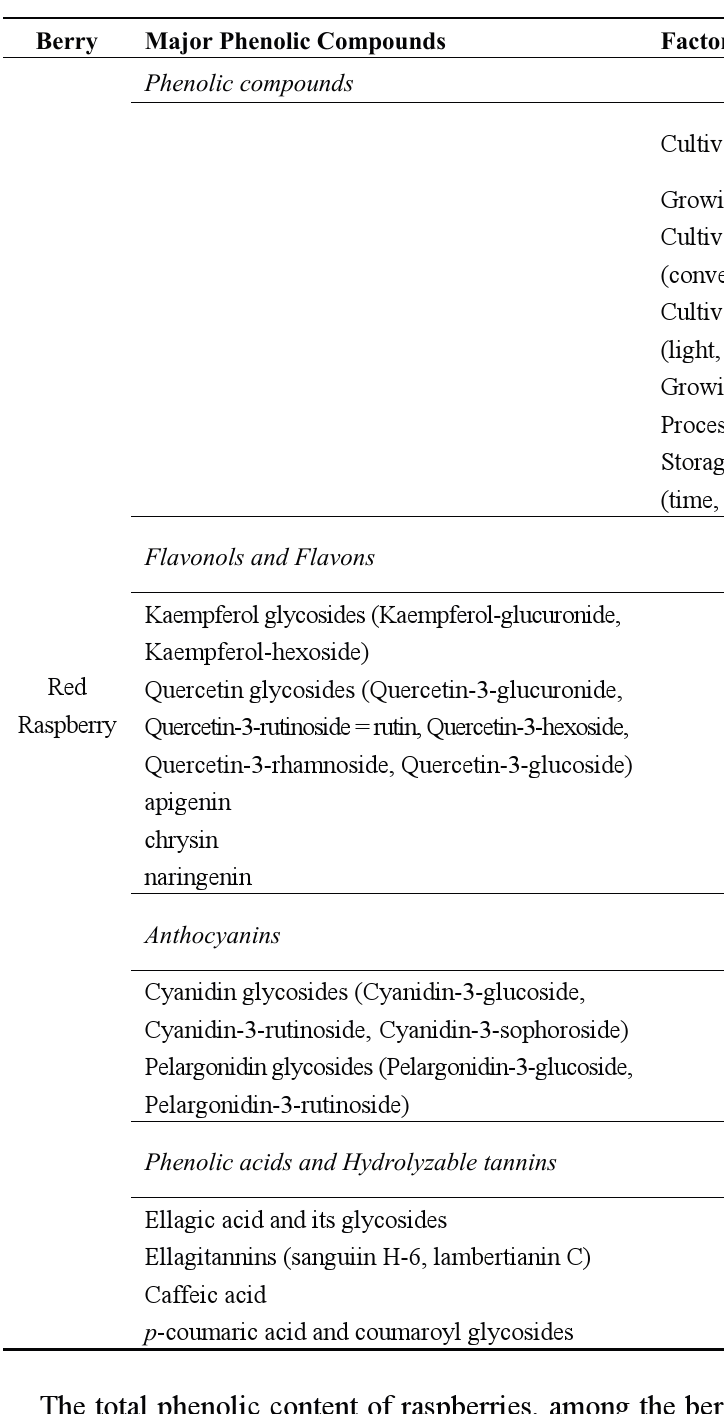
Table 2. Phenolic composition and factors influencing the composition of red